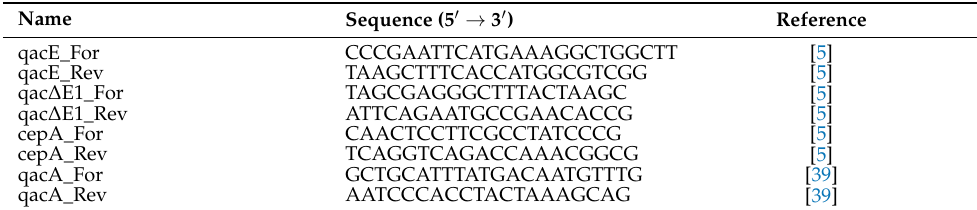
Table 5. Primers used in this study.